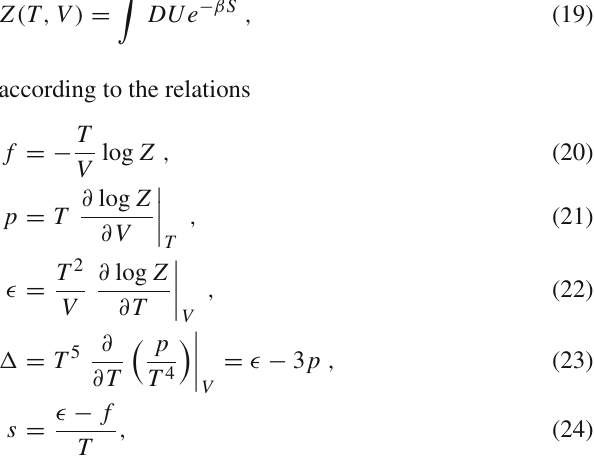
to discretisation effects, which increase when β decreases, and which are not universal; see Ref.